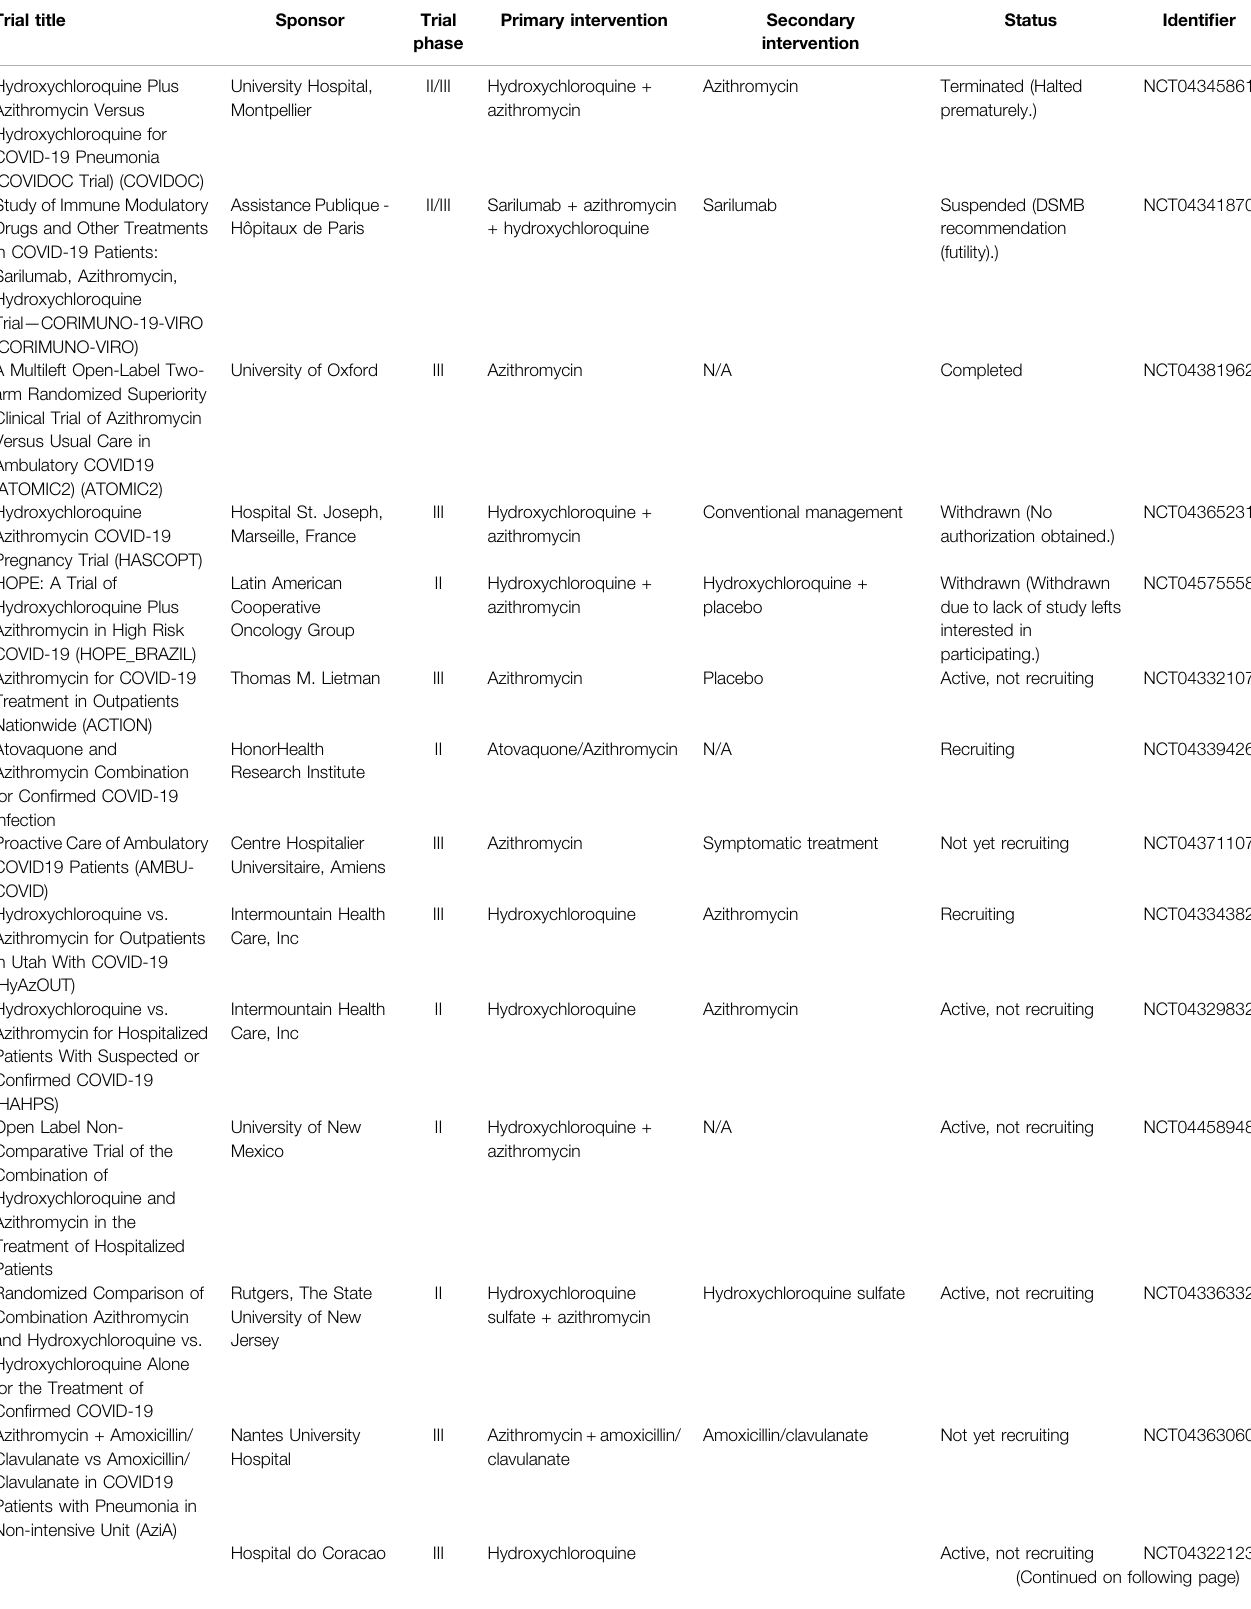
TABLE 6 | Summary of clinical trials of azithromycin on COVID-19